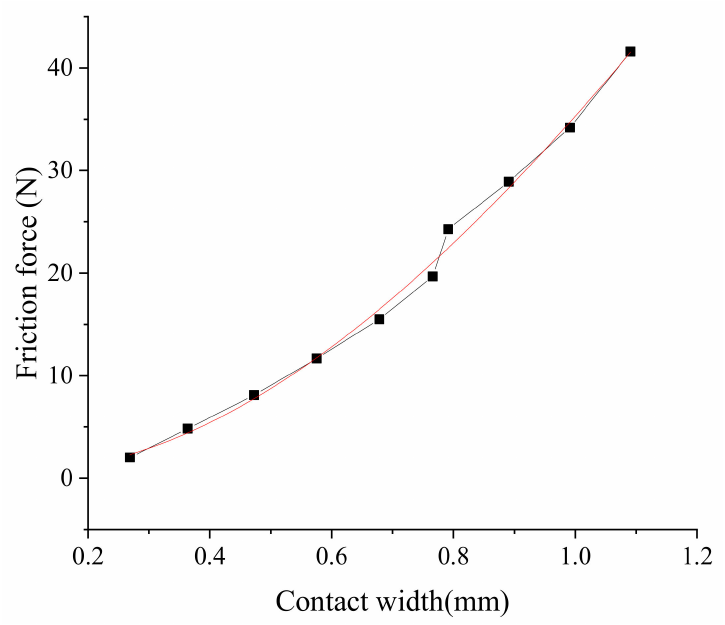
Figure 9. Friction under different contact widths.